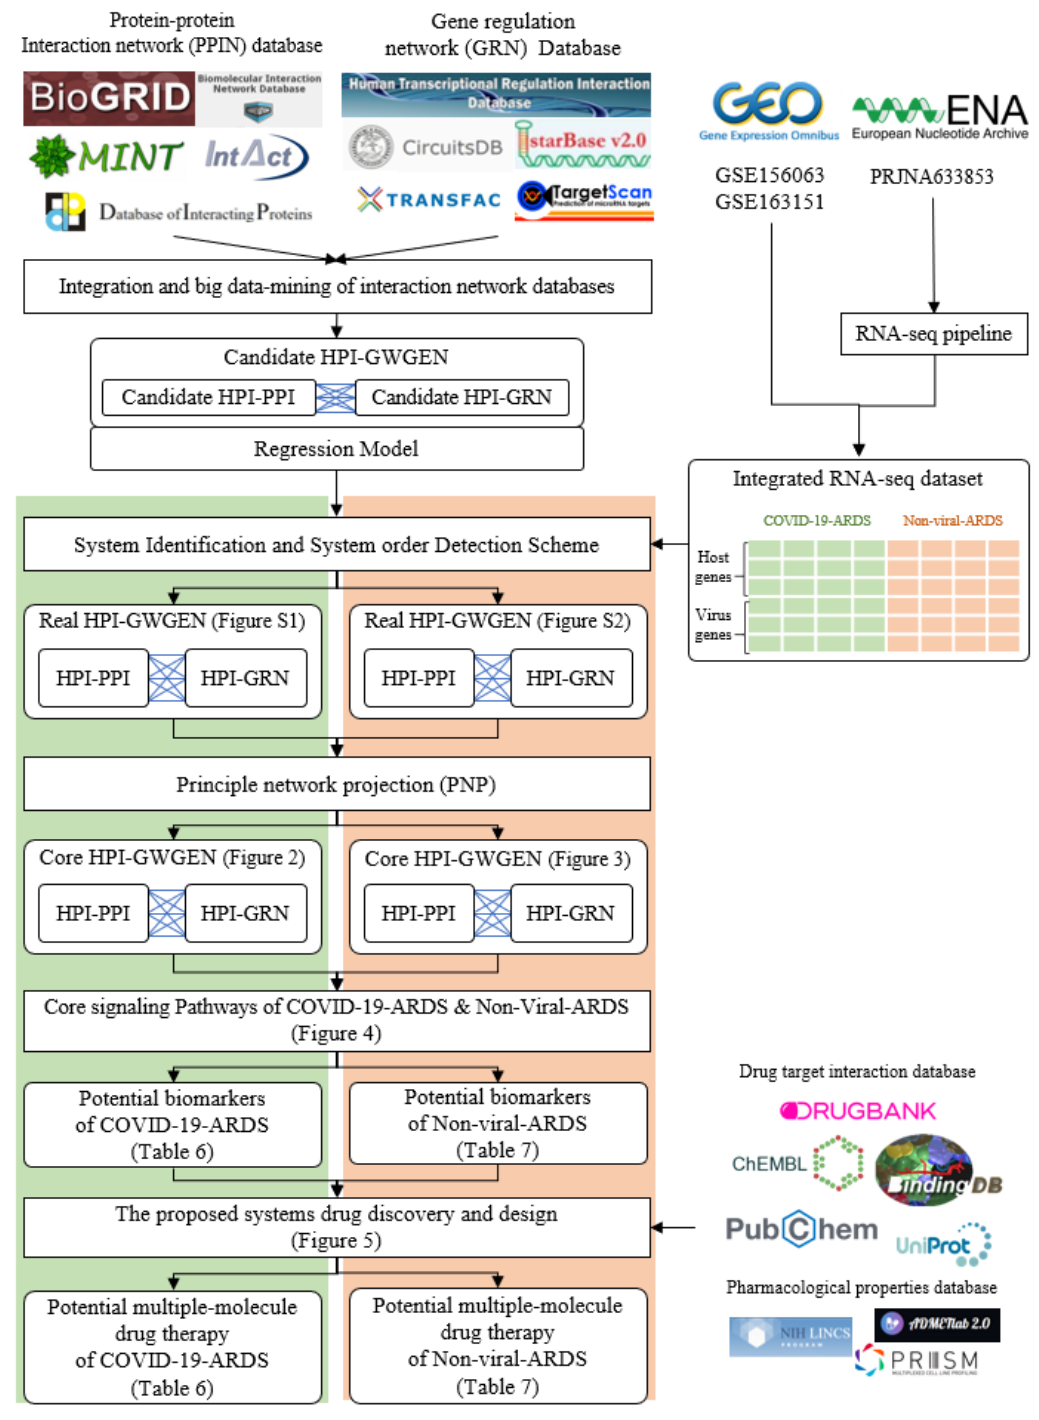
Figure 1. The flowchart for constructing candidate HPI-GWGEN, real HPI-GWGEN, core HPI- GWGEN, and core signaling pathways for biomarker identification for systems drug discovery and design of potential multiple-molecule drugs for therapeutic treatment of COVID-19-associated ARDS and non-viral ARDS.